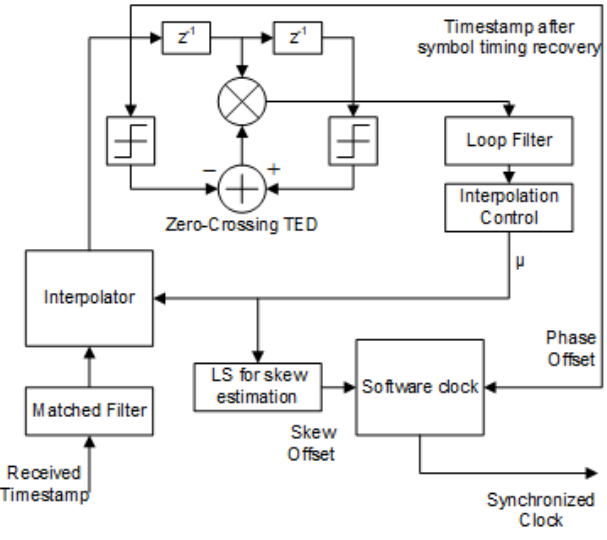
Figure 4. Single-timestamp skew-correction (STSC) model.